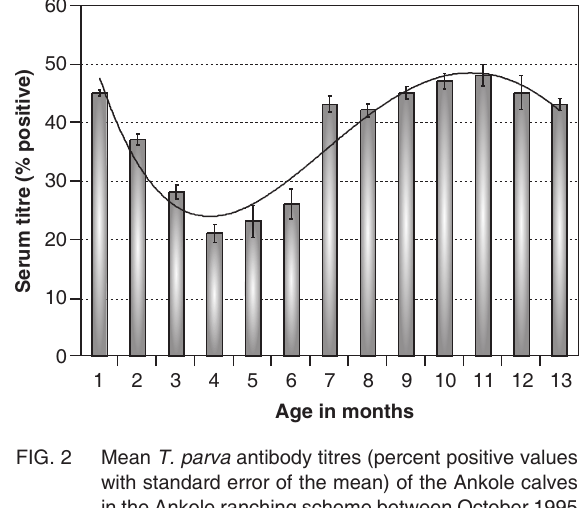
FIG. 1 East Coast Fever cumulative calf mortality by month of age in the Ankole ranching scheme between October 1995 and April 1997